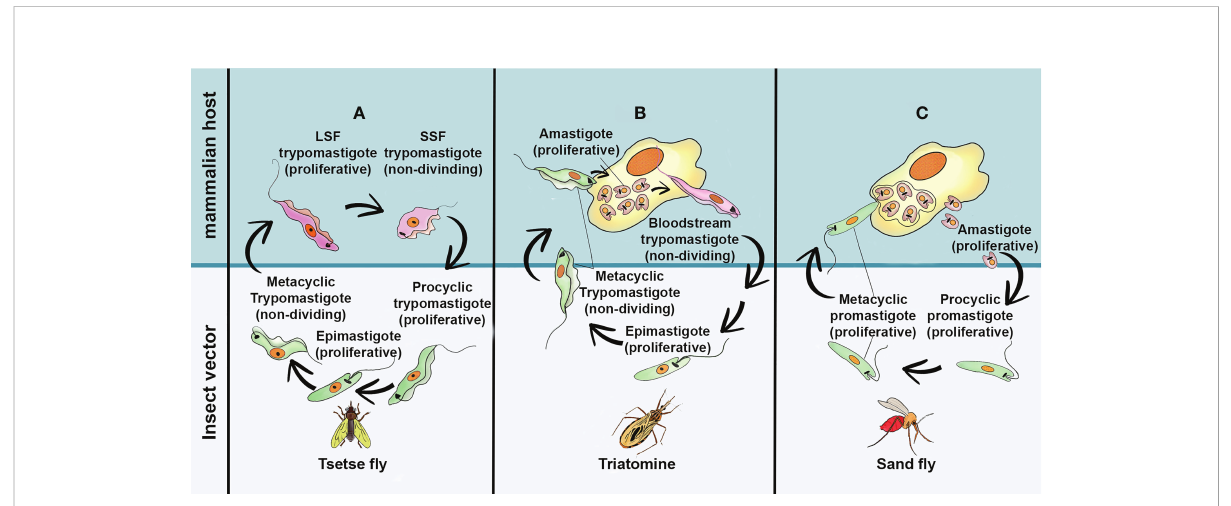
FIGURE 1 The simpli fi ed life cycle of most relevant pathogenic Trypanosomatids: (A) Trypanosoma brucei (B) Trypanosoma cruzi and (C) Leishmania spp. Long Slend Form (SLF); Short Stump Form (SSP). This freehand digital illustration was made using Procreate ® and Adobe Photoshop ®